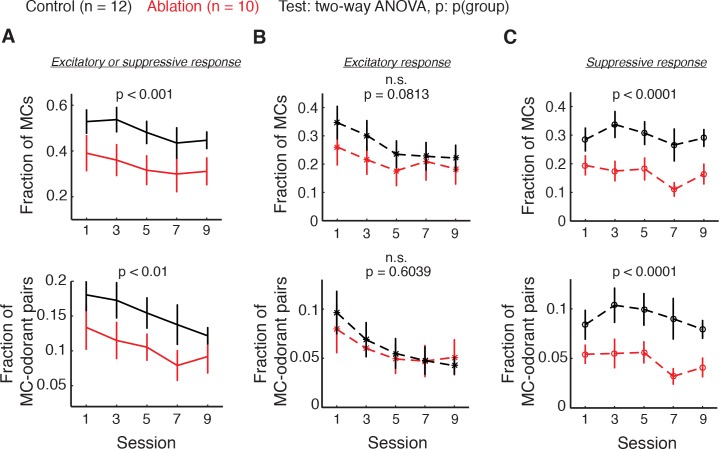
Fraction of responsive MCs (top) and responsive MC-odorant pairs (bottom) during the difficult discrimination task.Control: n = 12; ablation: n = 10. Mean ±S.E.M. (A) MCs with either excitatory or suppressive responses. Fraction of MCs: p<0.001; fraction of MC-odorant pairs: p<0.01. (B) MCs with excitatory responses. Fraction of MCs: p=0.0813; fraction of MC-odorant pairs: p=0.6039. (C) MCs with suppressive responses. Fraction of MCs: p<0.0001; fraction of MC-odorant pairs: p<0.0001. All p values are for two-way ANOVA, control vs. ablation. Note that a given MC can have excitatory responses to some odorants and suppressive responses to others, and thus the total response is not necessarily a sum of excitatory and suppressive.